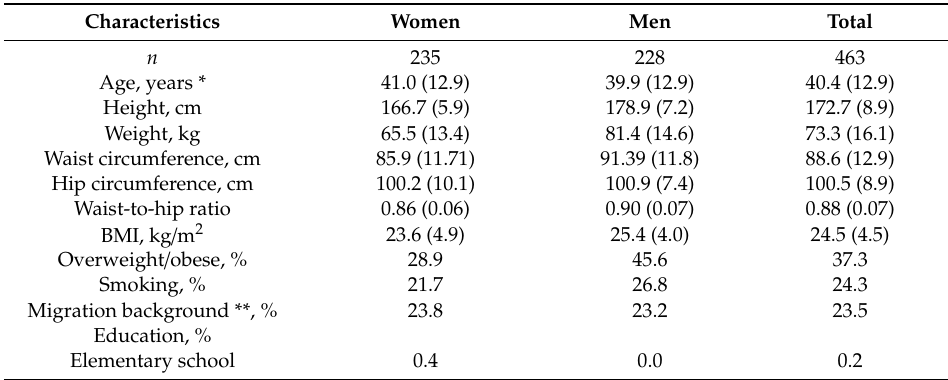
Table 2. Characteristics of the study